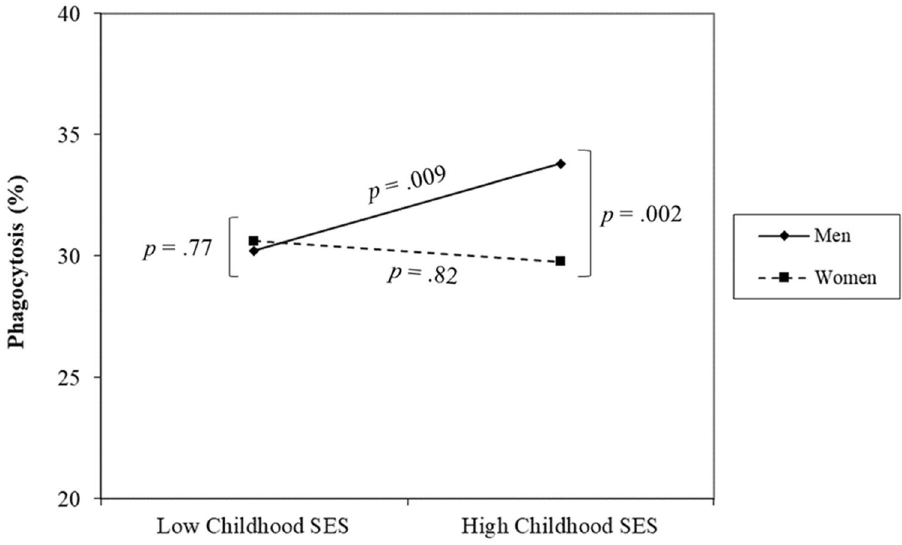
Figure 1. Interaction between childhood socioeconomic status (SES) and sex on phagocytosis of Escherichia coli bioparticles by peripheral blood mononuclear cells. High and low SES refer to one standard deviation above and below the mean of this variable, respectively.